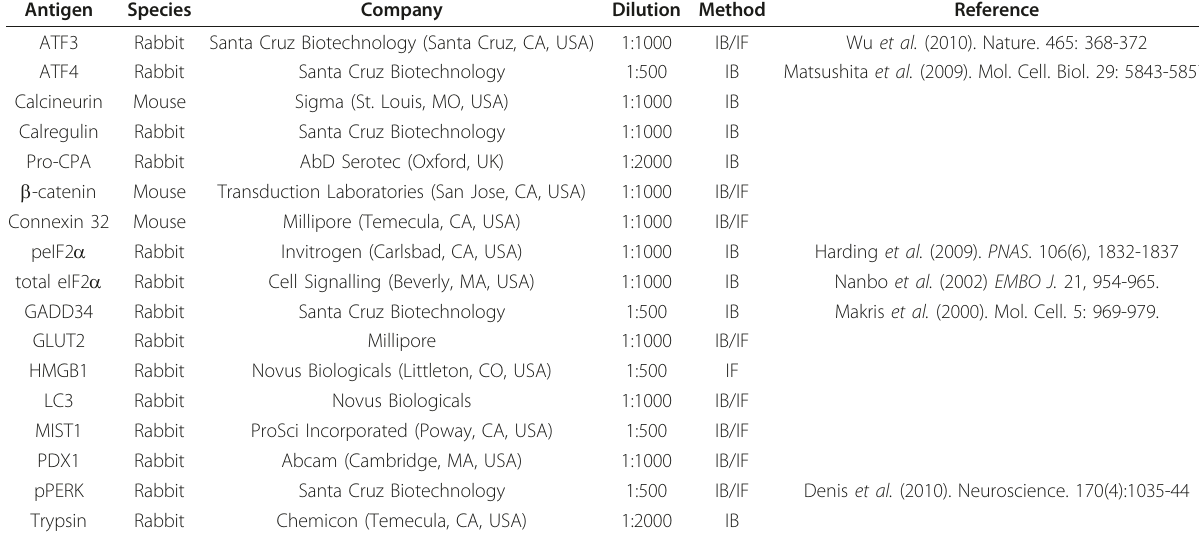
Table 1 List of Primary Antibodies Used in Fazio et al (2011) Antigen